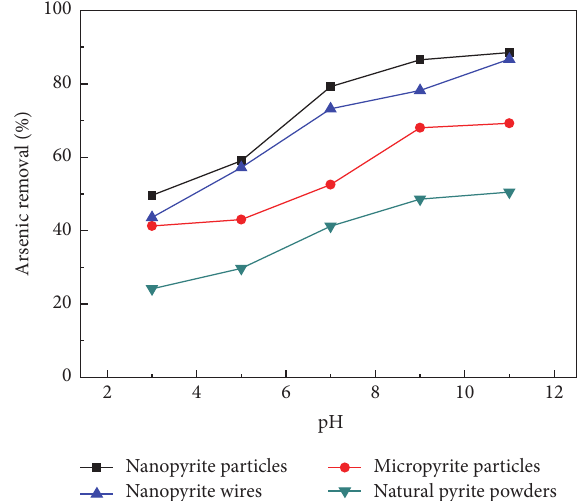
Figure 3: Effect of contact time on sorption of arsenic (pH = 7 , initial arsenic concentration of 30 mgL −1 ).